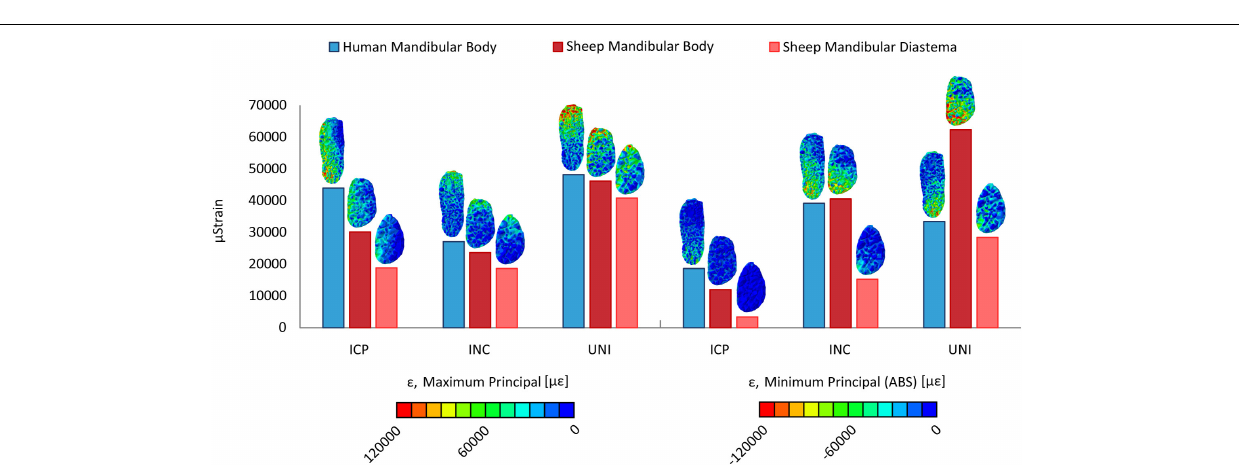
FIGURE 5 | Distribution and average values of the maximum and minimum principal strains ( ε ) within the fracture gap, in the human and sheep models, for the intercuspal (ICP), incisal (INC), and unilateral (UNI) clenching tasks.